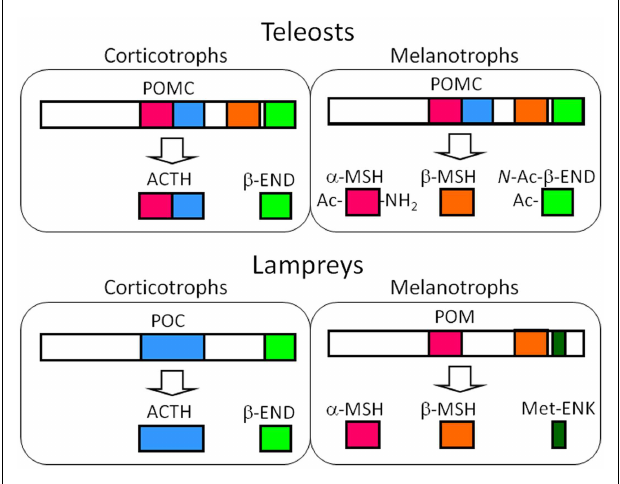
glands based on the results from the barfin flounder ( Verasper moseri ) (14, 46, 50) and sea lamprey ( Petromyzon marinus ) (14, 57–59) . In the original paper on the sea lamprey POMC, α -MSH, and β -MSH are termed MSH-B and MSH-A, respectively (59).The major products in these cells are common between teleosts and lampreys – ACTH and END in the melanotrophs, and MSHs and opioid peptides, i.e., N -Ac- β -END or Met-ENK.The differences between teleosts and lampreys lie in the genes expressed; identical POMCs are generated in the corticotrophs